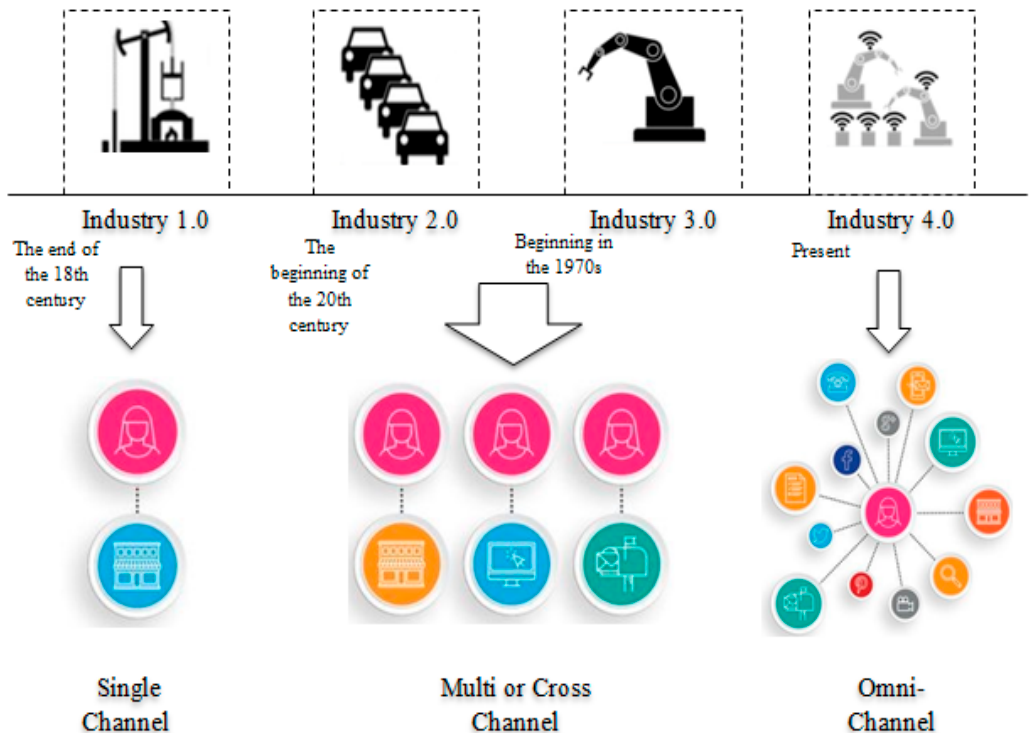
Figure 13. The relationship of communication channels in the Industry Revolution. Source: Own contribution of the authors.